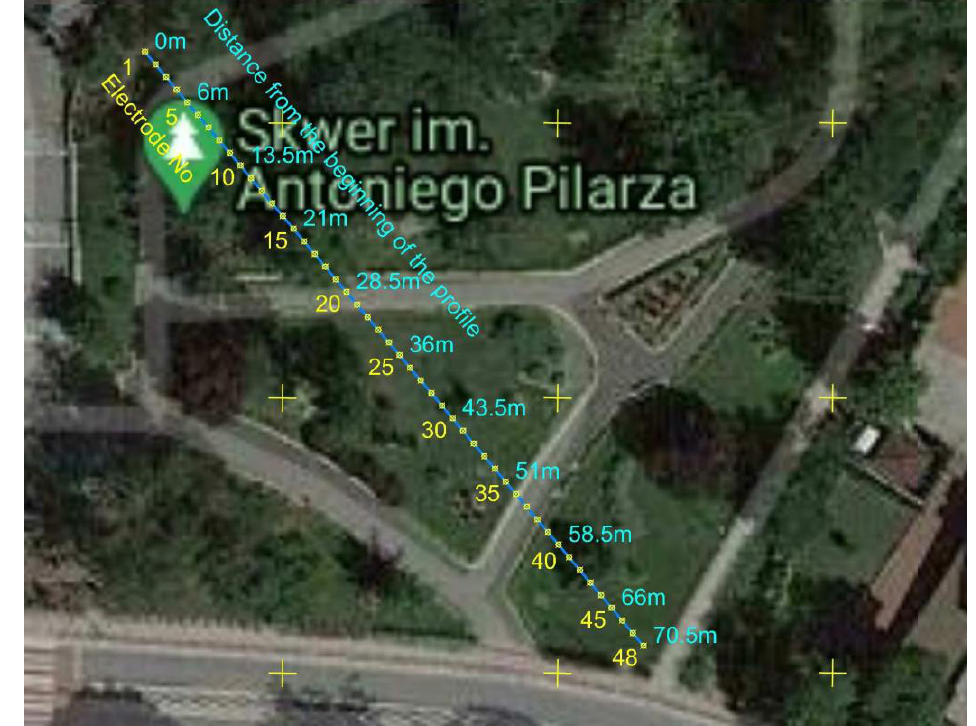
Figure 7. The location of the ERT profile in relation to the surface development.